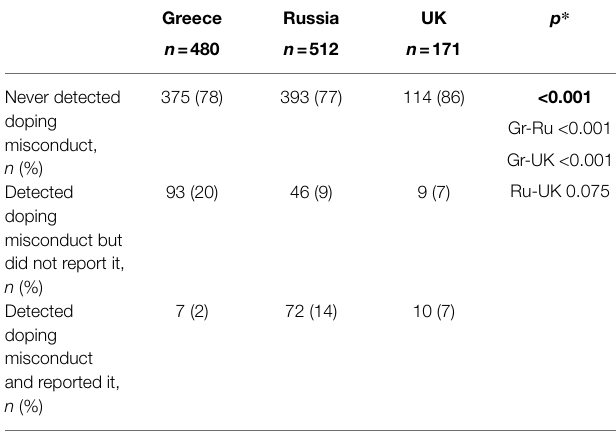
TABLE 2 | Trust in different whistleblowing reporting systems. TABLE 3 | Whistleblowing